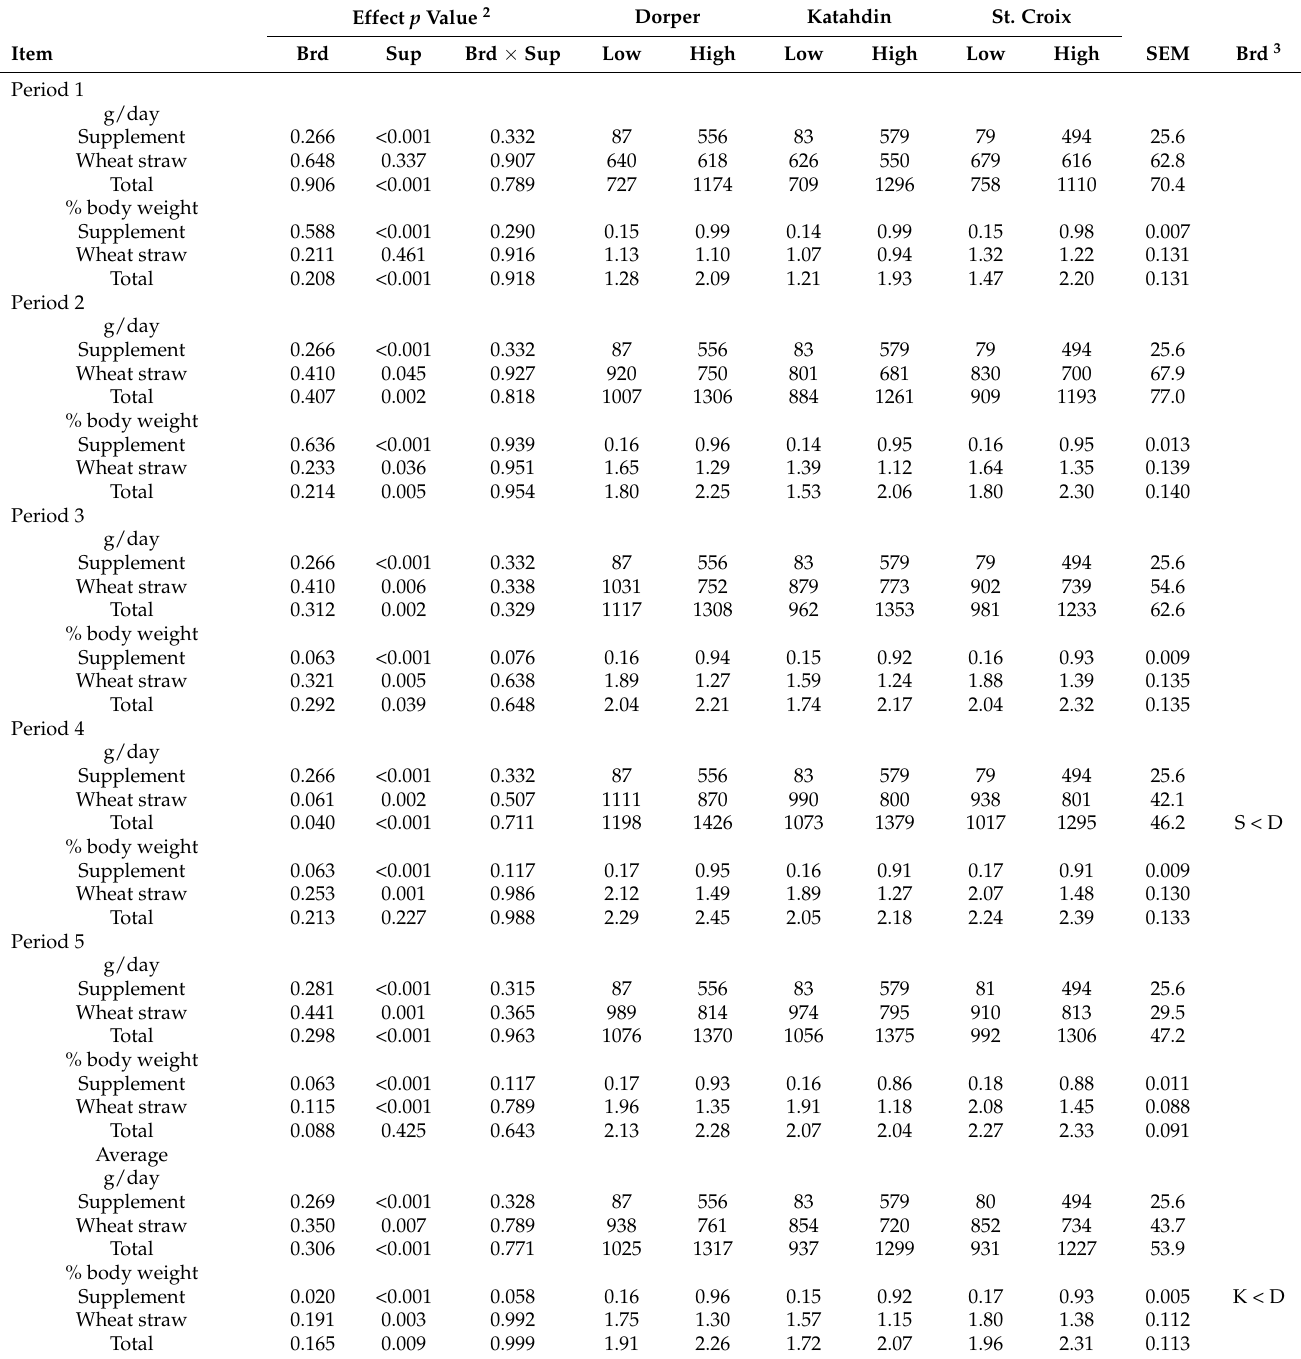
Table 2. Effects of breed and supplement treatment on dry matter intake by hair sheep 1